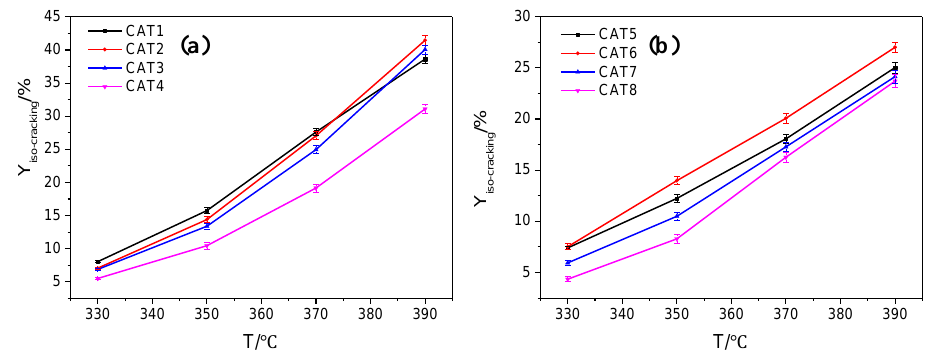
Figure 8. The relationship of yields of iso-cracking and temperature over catalysts ( a ) CAT1 – CAT4 and ( b ) CAT5 – CAT8.